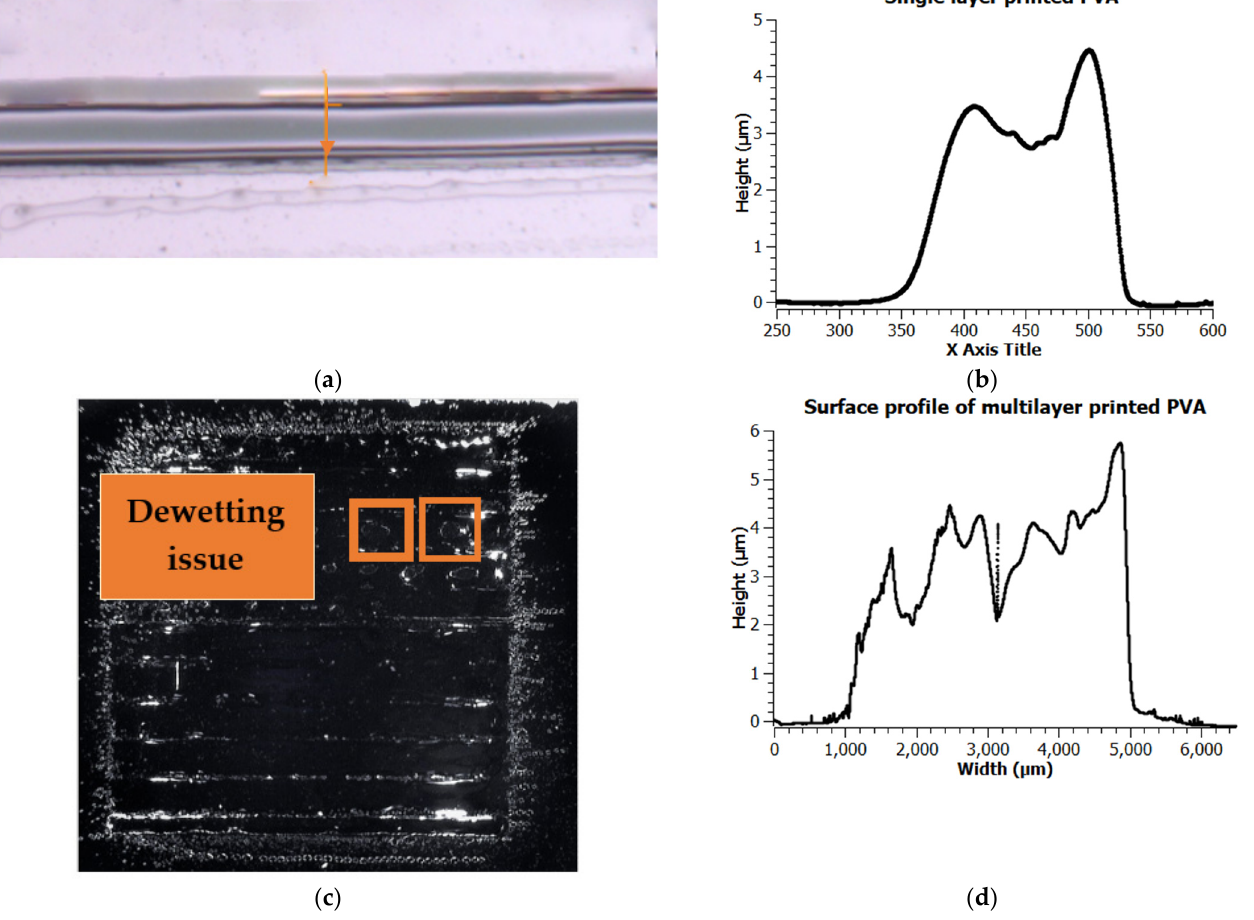
Figure 8. Printed PVA on Silicon substrate ( a ) (ii) 5000 µm × 150 µm line. ( b ) Thickness of the line; ( c ) 5000 µm × 5000 µm square. ( d ) Thickness of the square.